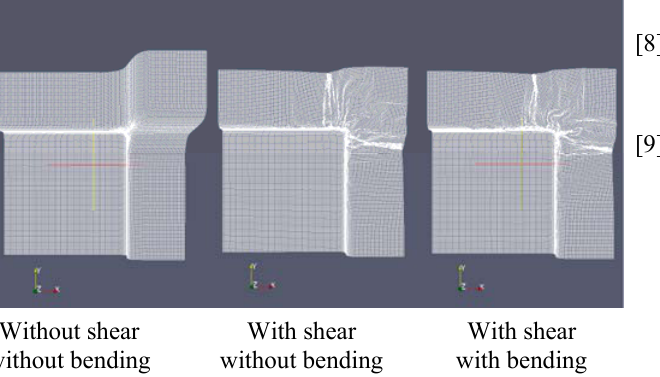
Fig 12: Simulation results of square box deep drawing